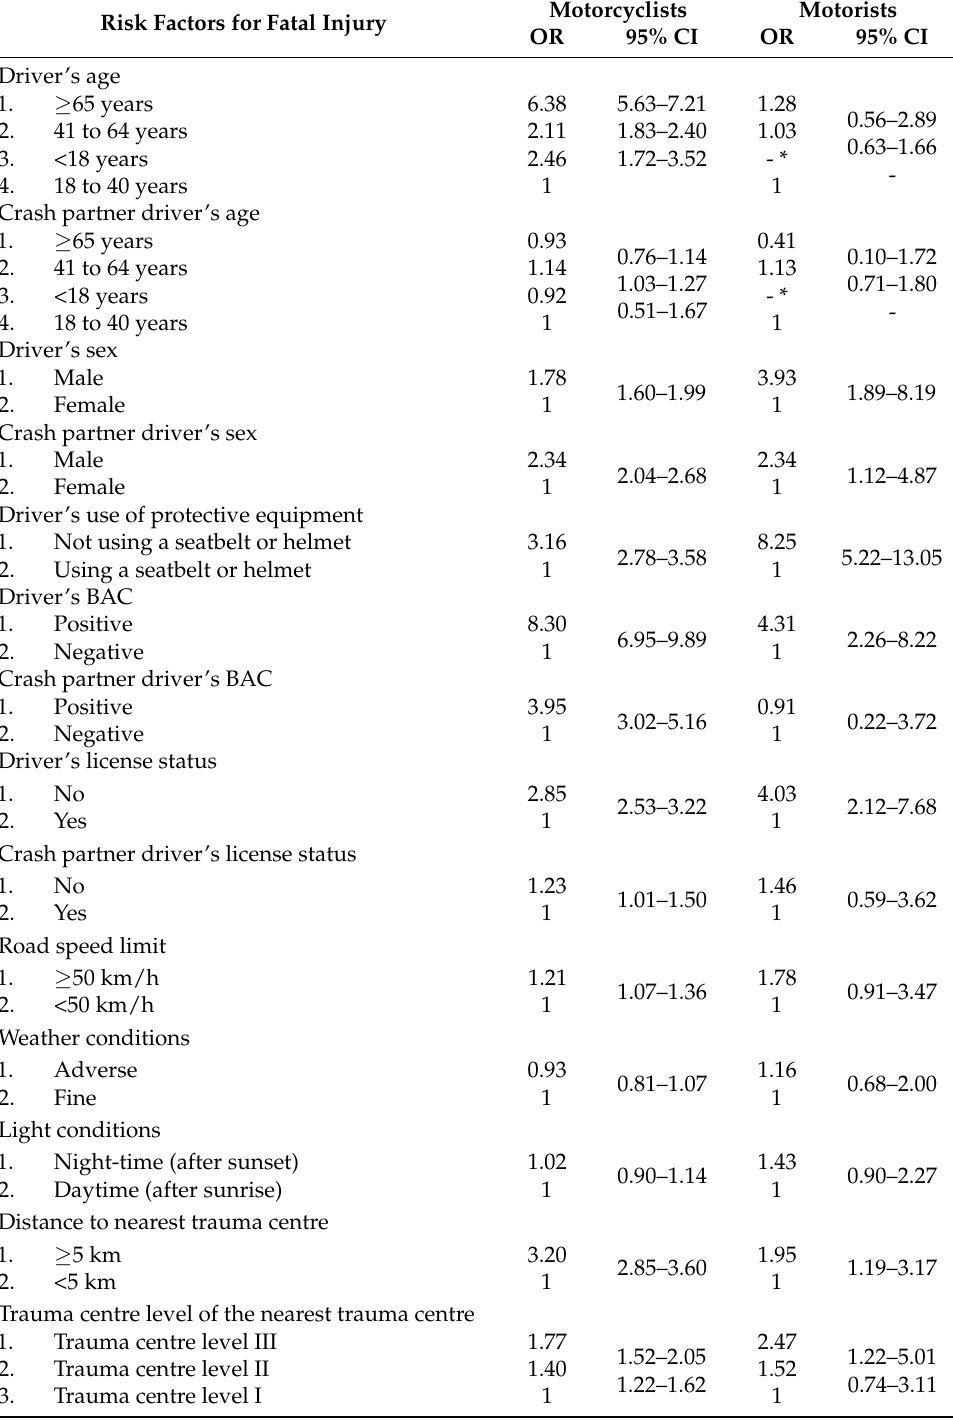
Table 3. Risk factors for fatal injuries among motorcyclists and